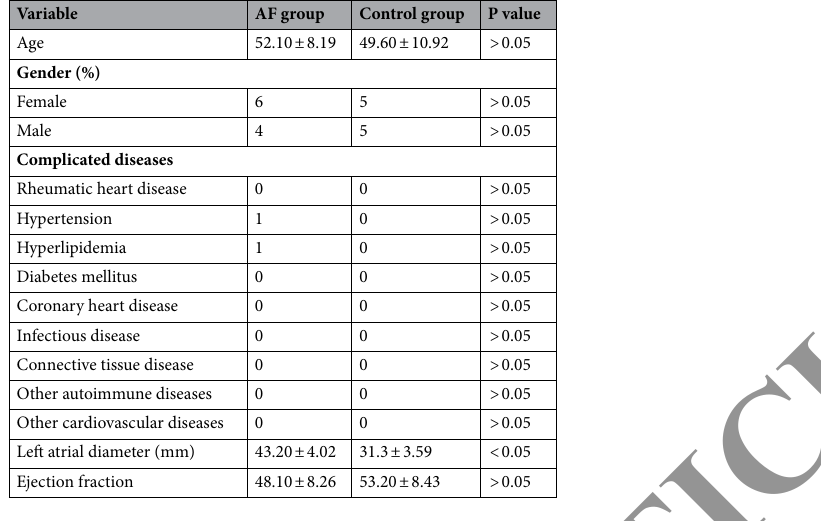
Table 1. Baseline characteristics of the